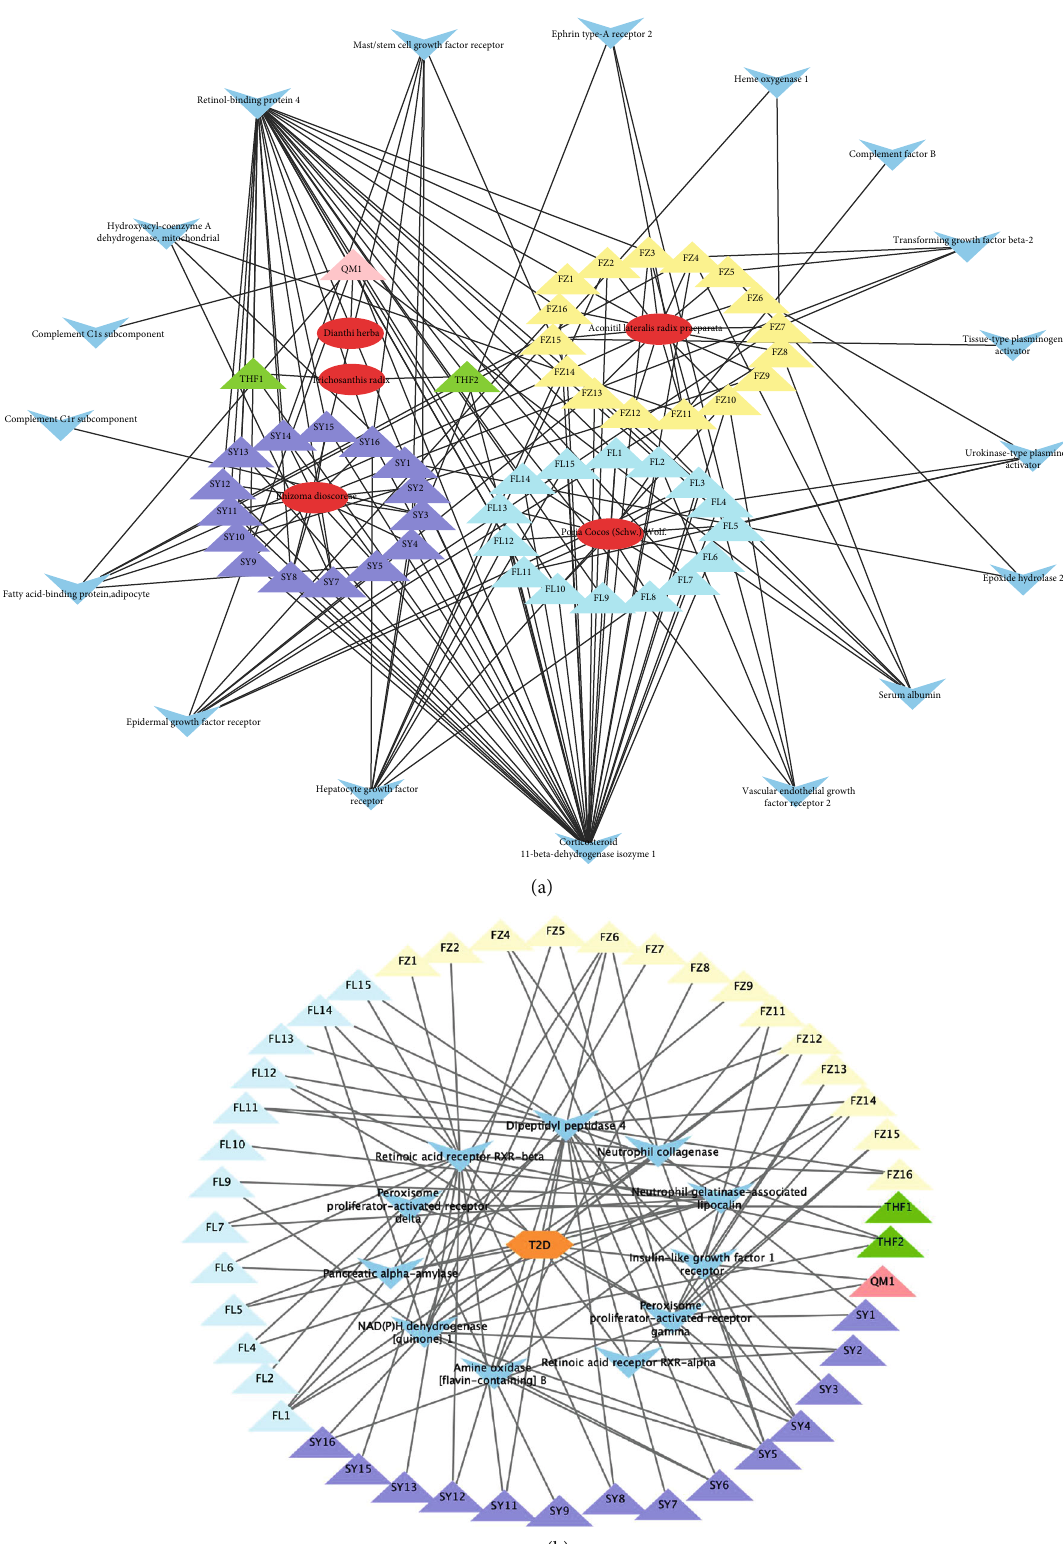
Figure 10: Interactions between herbs and target proteins for compounds. (a) The ovals represent herbs; the triangles represent the compounds of herbs, and di ff erent colors represent the source of the compound; the blue darts represent the intersecting target proteins between GLQMW and process of ND-IGT-T2D. (b) Hexagons represent T2D; the triangles represent the compounds of herbs, and di ff erent colors represent the source of the compound; blue darts represent clinical drug